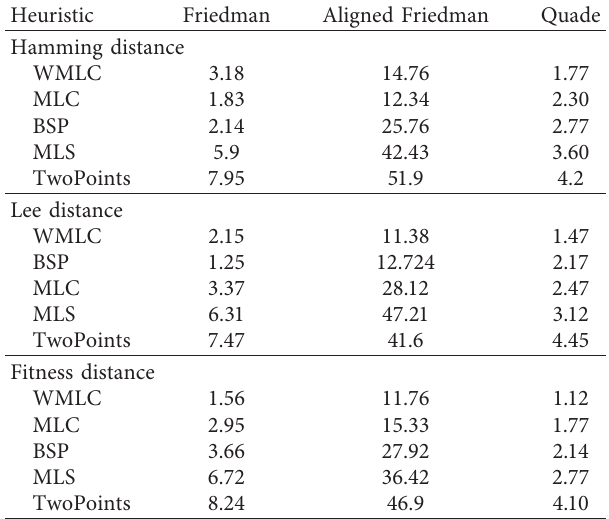
Table 1: Ranking of the course timetabling heuristics. Heuristic Friedman